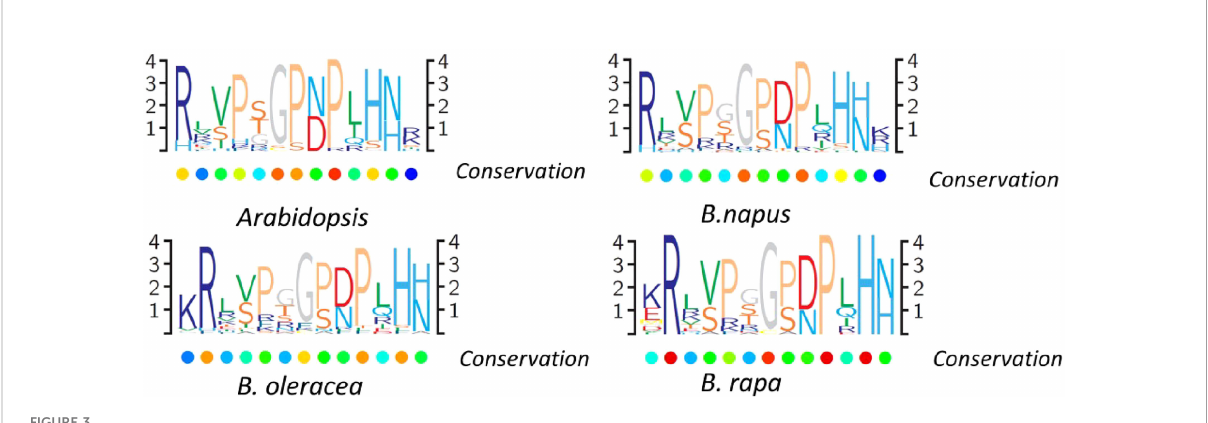
FIGURE 3 CLAVATA3/EMBRYO SURROUNDING (CLE) domain consensus sequences from Brassica napus , Brassica rapa , Brassica oleracea , and Arabidopsis pre-propeptides. Logo diagrams illustrate the 13 amino acid CLE domain consensus sequences, determined from multiple sequence alignments generated for each